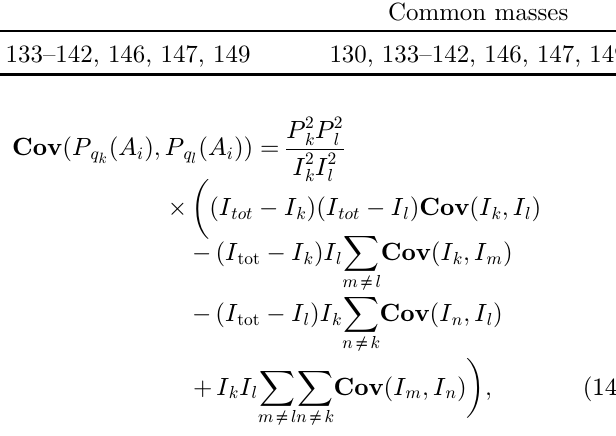
Table 1. Set of masses measured in the two experiments and masses common to the two experiments. Exp.1 Exp.2